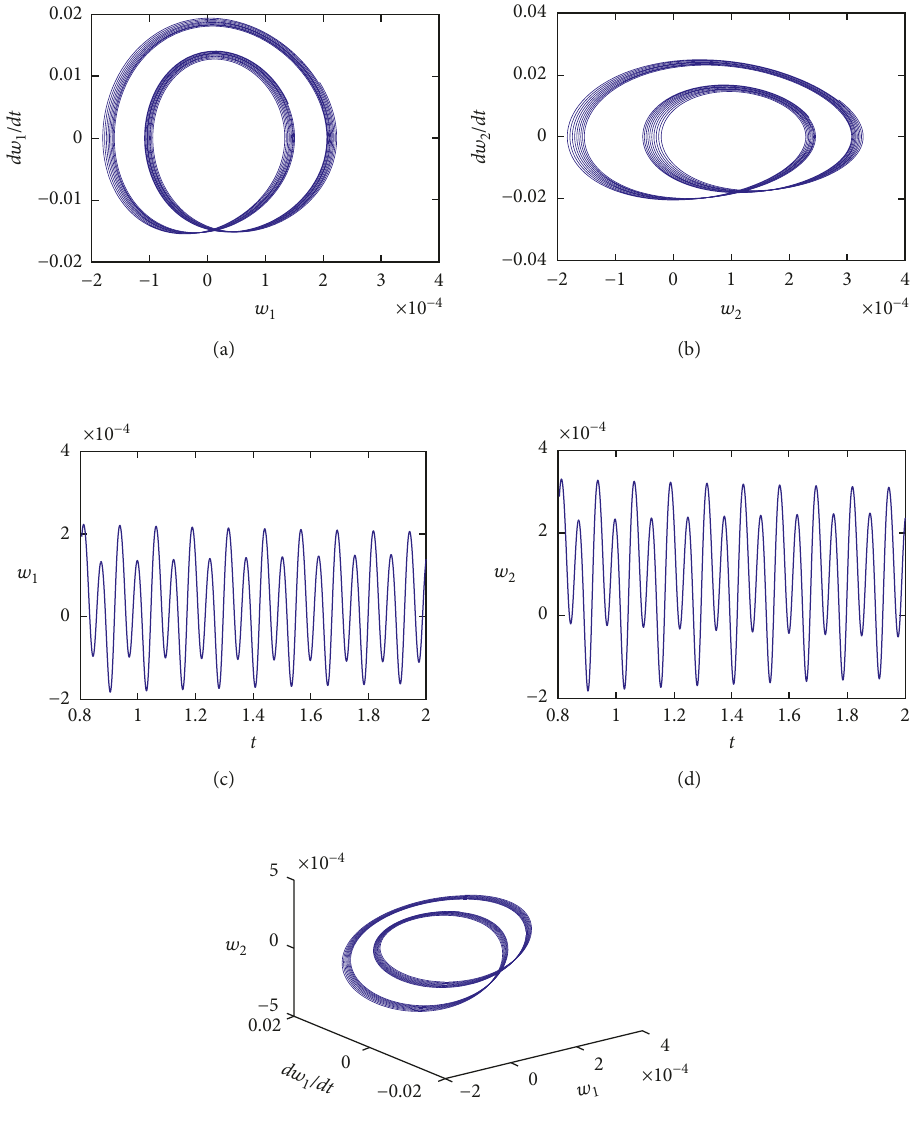
Figure 9: Multiperiodic motions of the cantilever honeycomb sandwich